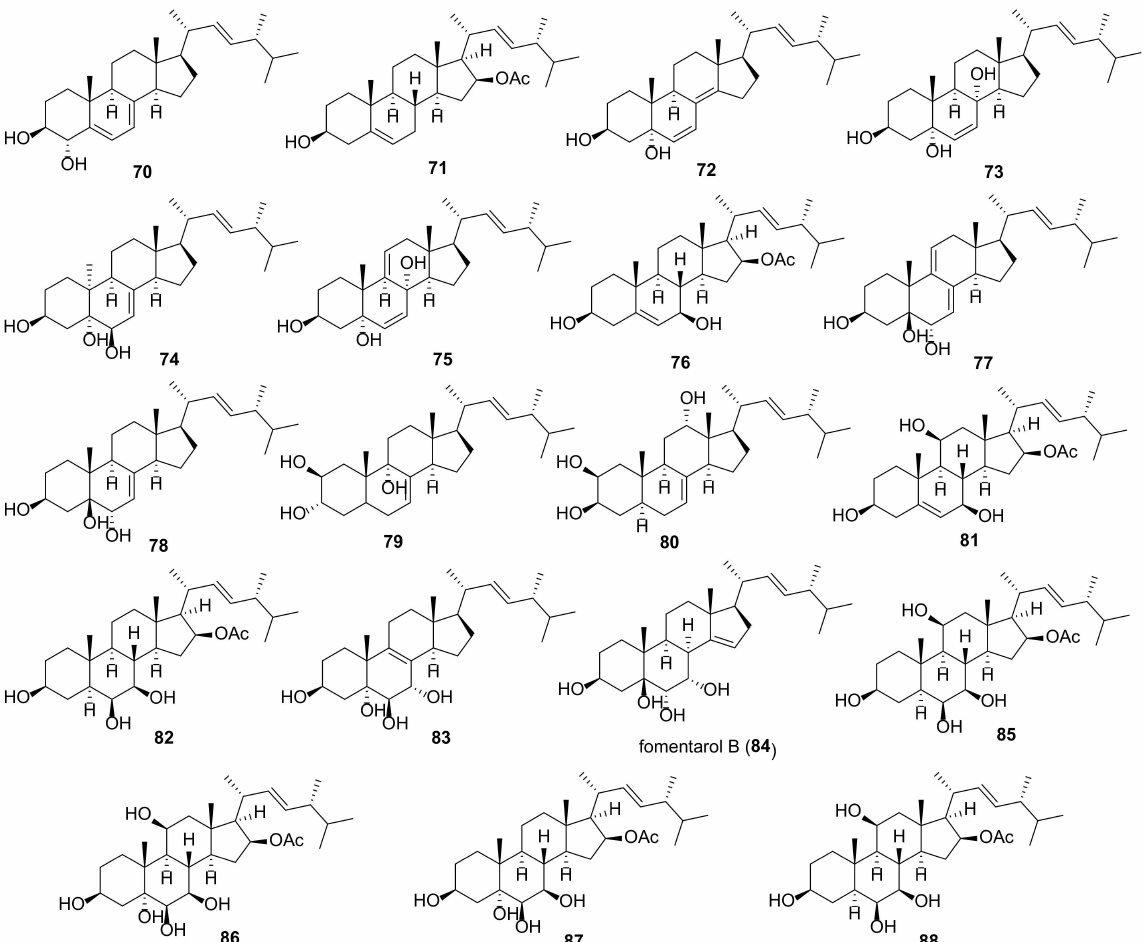
Figure 10. Structures of other fungal